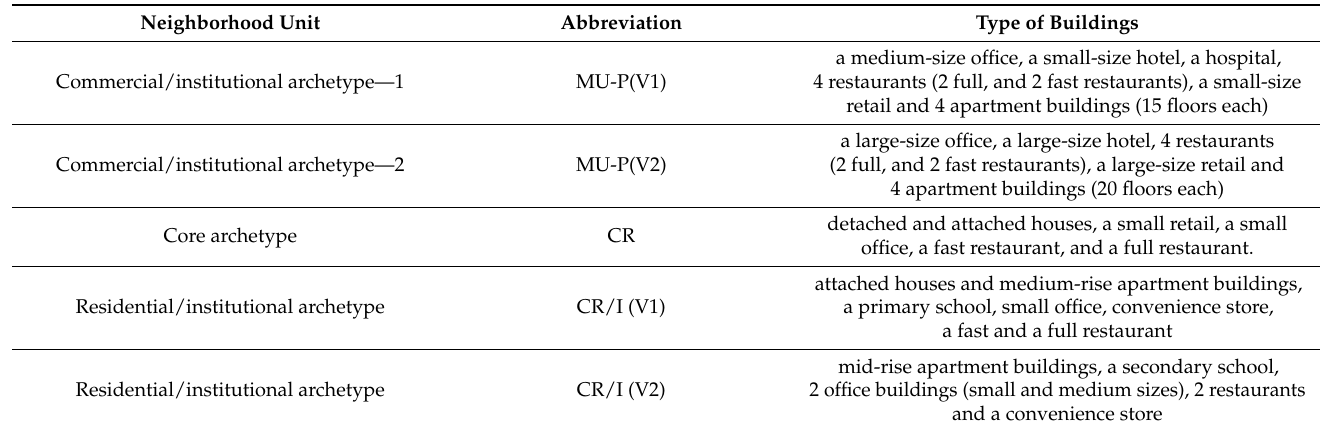
Table 1. Details of each neighborhood unit